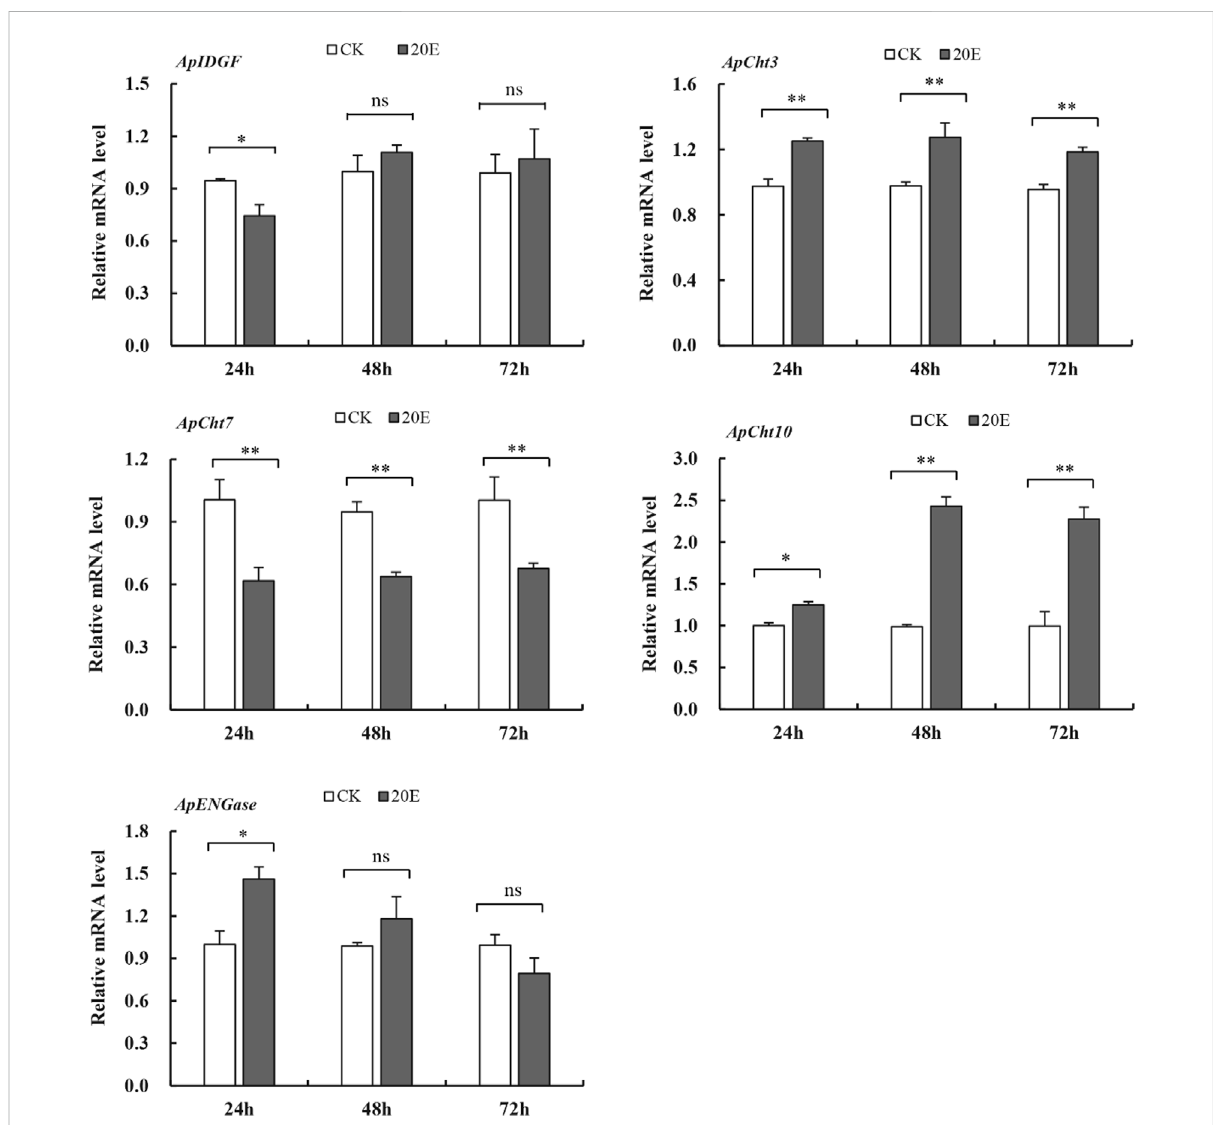
FIGURE 7 Expression of the Cht-related genes in response to 20E treatment. Different letters on the top of the columns indicate signi fi cance in the difference of expression levels by Tukey ’ s HSD test at same treatment time (* p < 0.05 and ** p < 0.01 compared with the control group).